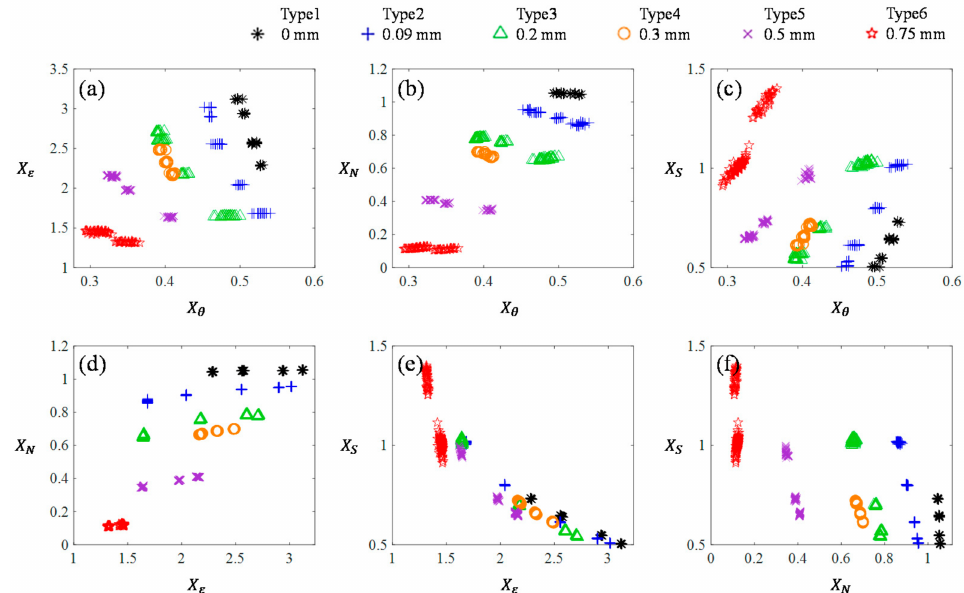
Figure 10. Distribution of original features in different two-dimensional spaces, the horizontal and vertical coordinates are the pairwise combinations of four characteristic variables respectively: X θ − X ε diagram ( a ), X θ − X N diagram ( b ), X θ − X S diagram ( c ), X ε − X N diagram ( d ) and X ε − X S diagram ( e ), X N − X S diagram ( f